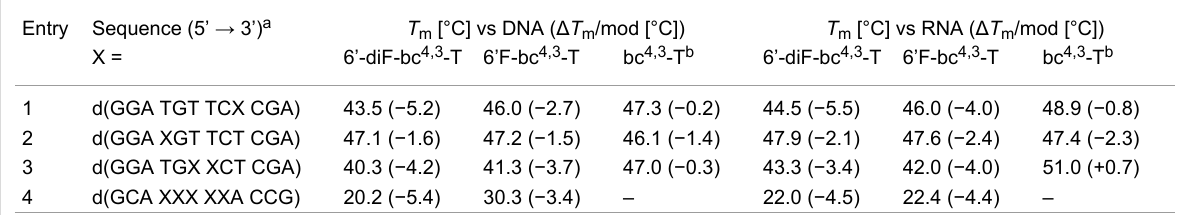
Table 3: T m and Δ T m /mod data from UV-melting curves (260 nm) of ONs containing 6’-diF-bc 4,3 -T, 6’F-bc 4,3 -T, or bc 4,3 -T residues in the DNA back- bone hybridized to complementary DNA and RNA. Entry Sequence (5’ → 3’)